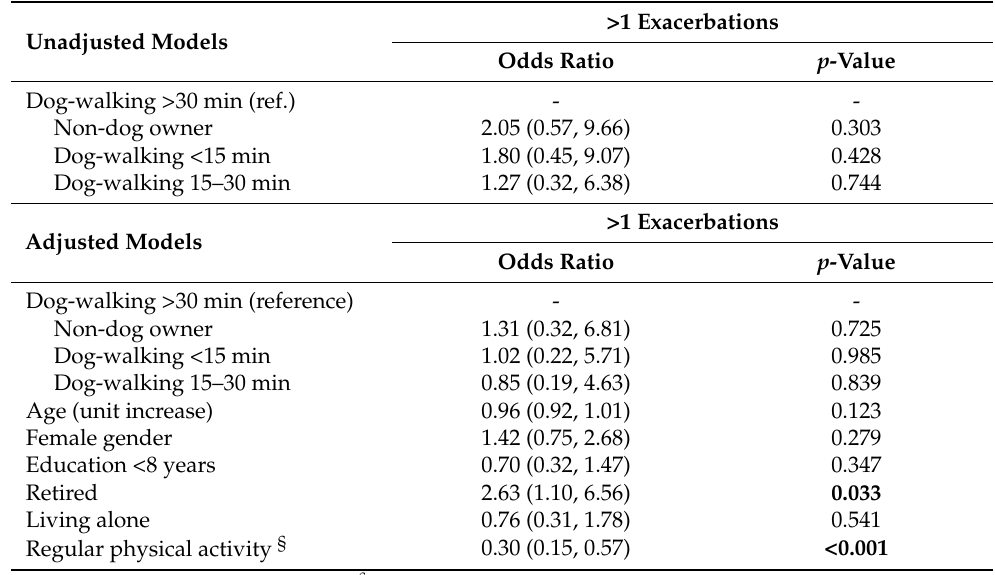
Table 4. Exacerbations: crude and adjusted odds ratios and 95% confidence intervals from logistic regression